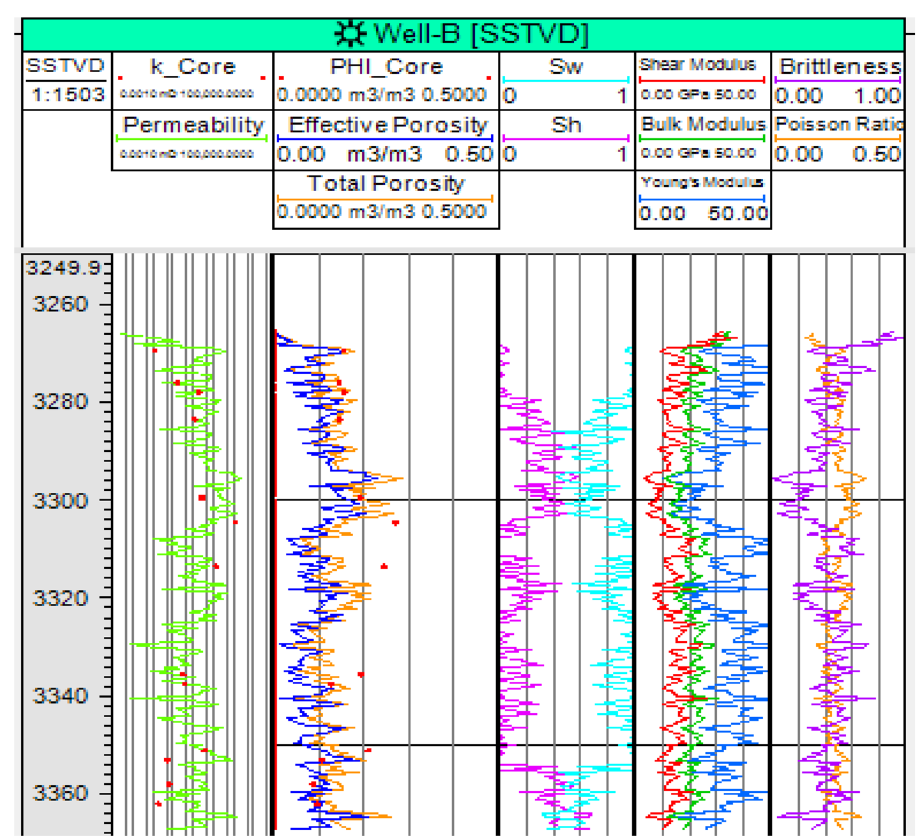
Fig. 13 Petrophysical